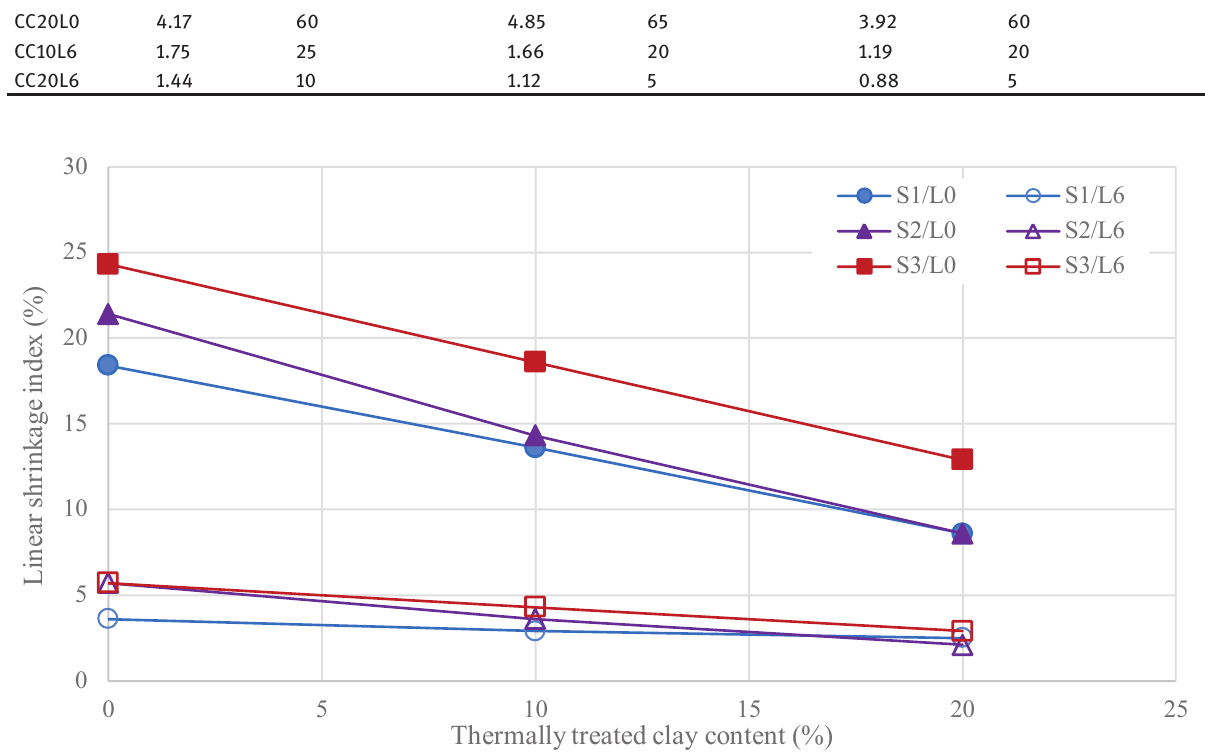
Figure 6. Pozzolanic activity numbers of clay soils treated at different temperatures